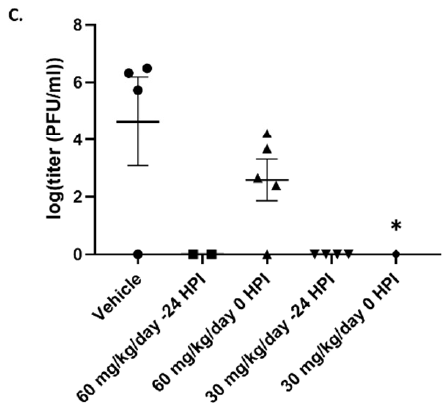
Figure 3. In vivo antiviral efficacy of Tilorone at different doses against RVFV infection in BALB/c mice. Mice (n = 10/group) were infected with 100 PFU RVFV ZH501 via the intraperitoneal (IP) route. Treatment with either 30 mg/kg/day or 60 mg/kg/day of Tilorone was initiated either 24 h before infection or immediately after infection. Tilorone or vehicle solution was administered once daily via the IP route for 9 days after initiation of treatment. ( A ) Survival of animals receiving Tilorone or vehicle. ( B ) Percent weight change of animals receiving Tilorone or vehicle. ( C ) Terminal viremia for euthanized moribund animals receiving Tilorone or vehicle. * p < 0.05, *** p < 0.001, **** p < 0.0001.